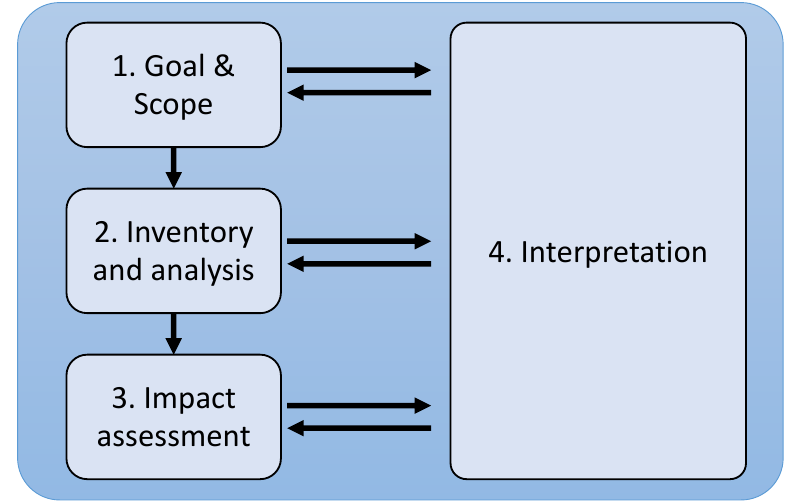
Figure 9. Framework LCA—ISO